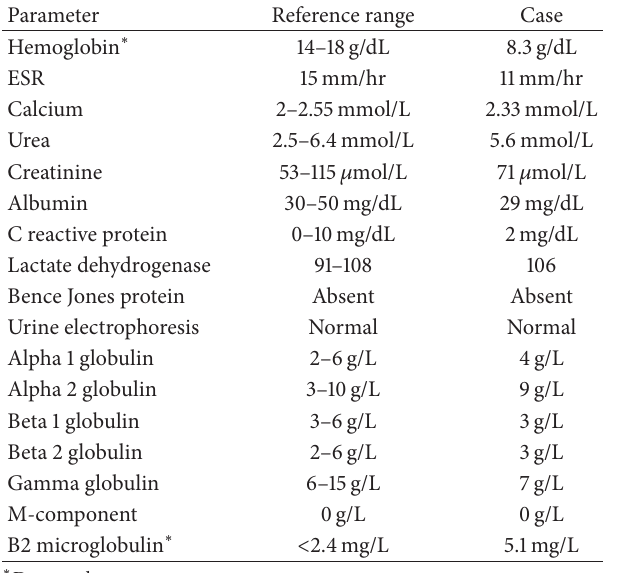
Table 1: Laboratory